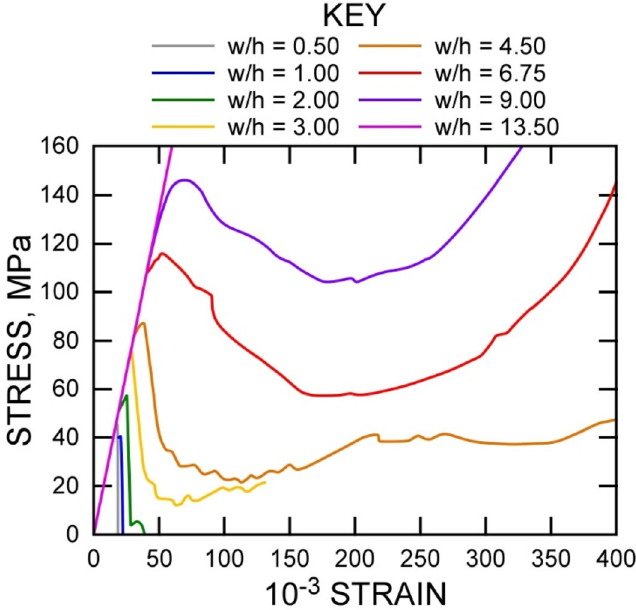
Fig. 9 Plots of experimental results of stress versus strain on coal according to various W/H ratios (after (Das 1986, Fig.